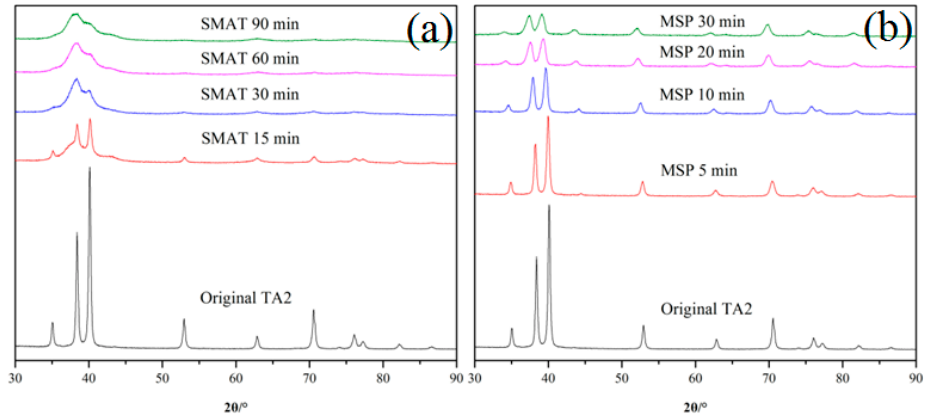
Figure 3. XRD patterns of the titanium specimen after different treatment conditions: ( a ) MSP and ( b ) SMAT.